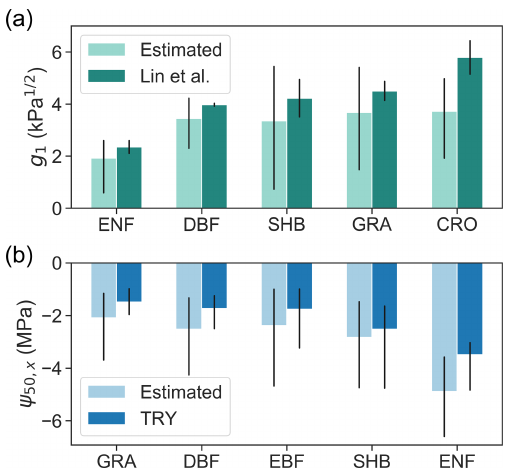
Figure 5. Retrieved (a) g 1 and (b) ψ 50 , x using model–data fusion (light colored bars), grouped by PFTs, in comparison with values derived from in situ measurements (dark colored bars) reported in Lin et al. (2015) and the TRY database (Kattge et al., 2011). Com- pared PFTs include evergreen needleleaf forest (ENF), deciduous broadleaf forest (DBF), evergreen broadleaf forest (EBF), shrub- land (SHB), grassland (GRA), and cropland (CRO). Bars represent medians of each PFT, and black lines indicate the 25th–75th per- centile ranges. The g 1 averaged across gymnosperm trees and an- giosperm trees from Lin et al. (2015) were compared to retrieved g 1 in pixels dominated by ENF and DBF, respectively.